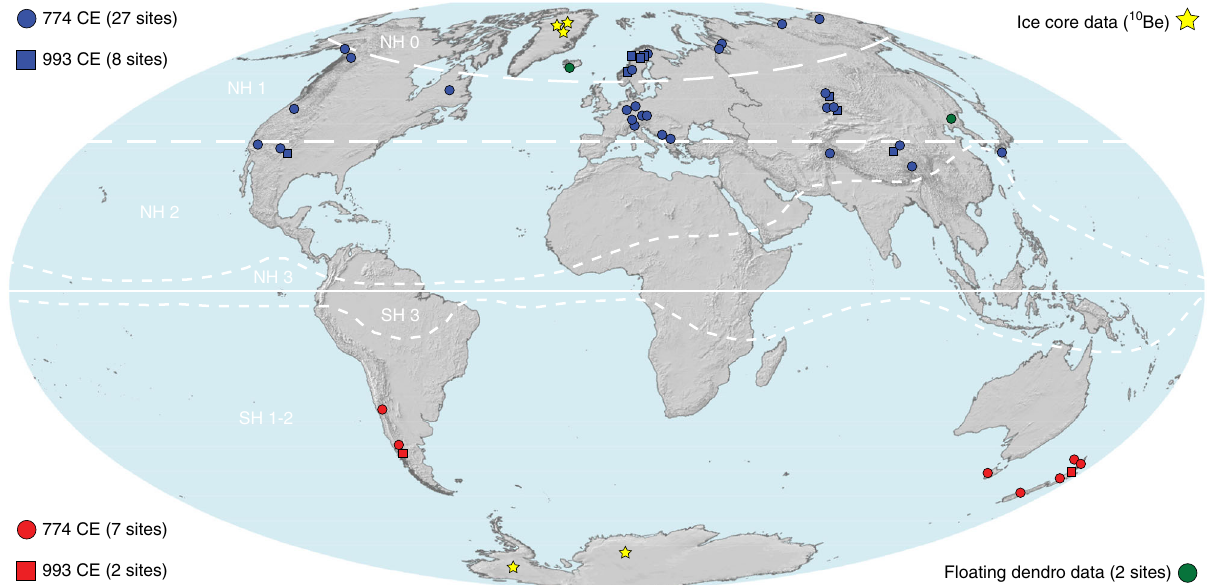
Fig. 1 COSMIC network. Distribution of 44 tree-ring records from which cellulose was extracted for annual 14 C measurements during the intervals 770 – 780 and 990 – 1000 CE (circles and rectangles) (Supplementary Fig. 1; Supplementary Tables 1-2). Independent 14 C evidence from two fl oating tree- ring chronologies 21, 22 (green), and fi ve (quasi) annually resolved ice-core 10 Be records 23,24 (yellow). White dashed lines refer to atmospheric radiocarbon zones 17 . The map re fl ects knowledge from the authors and was created via software ArcGIS 10.1 SP1 for Desktop by